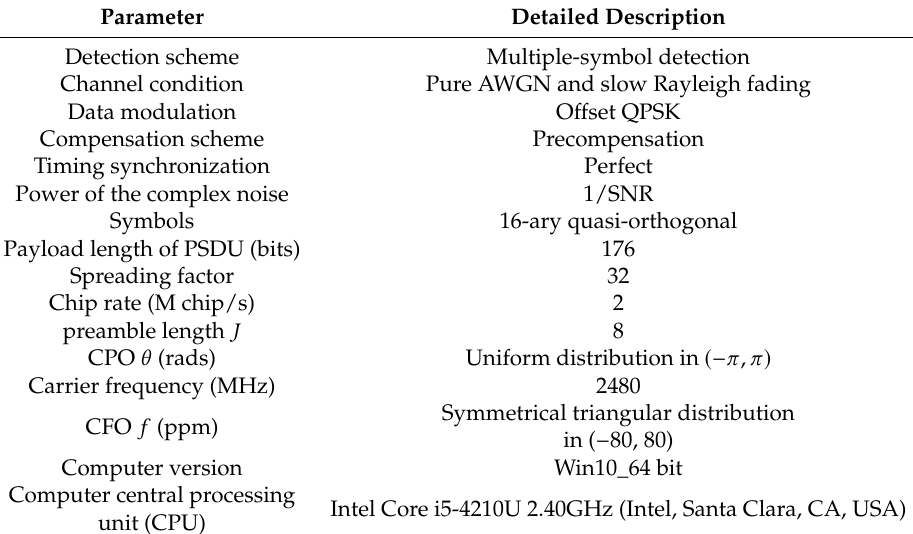
Table 1. Parameters used in